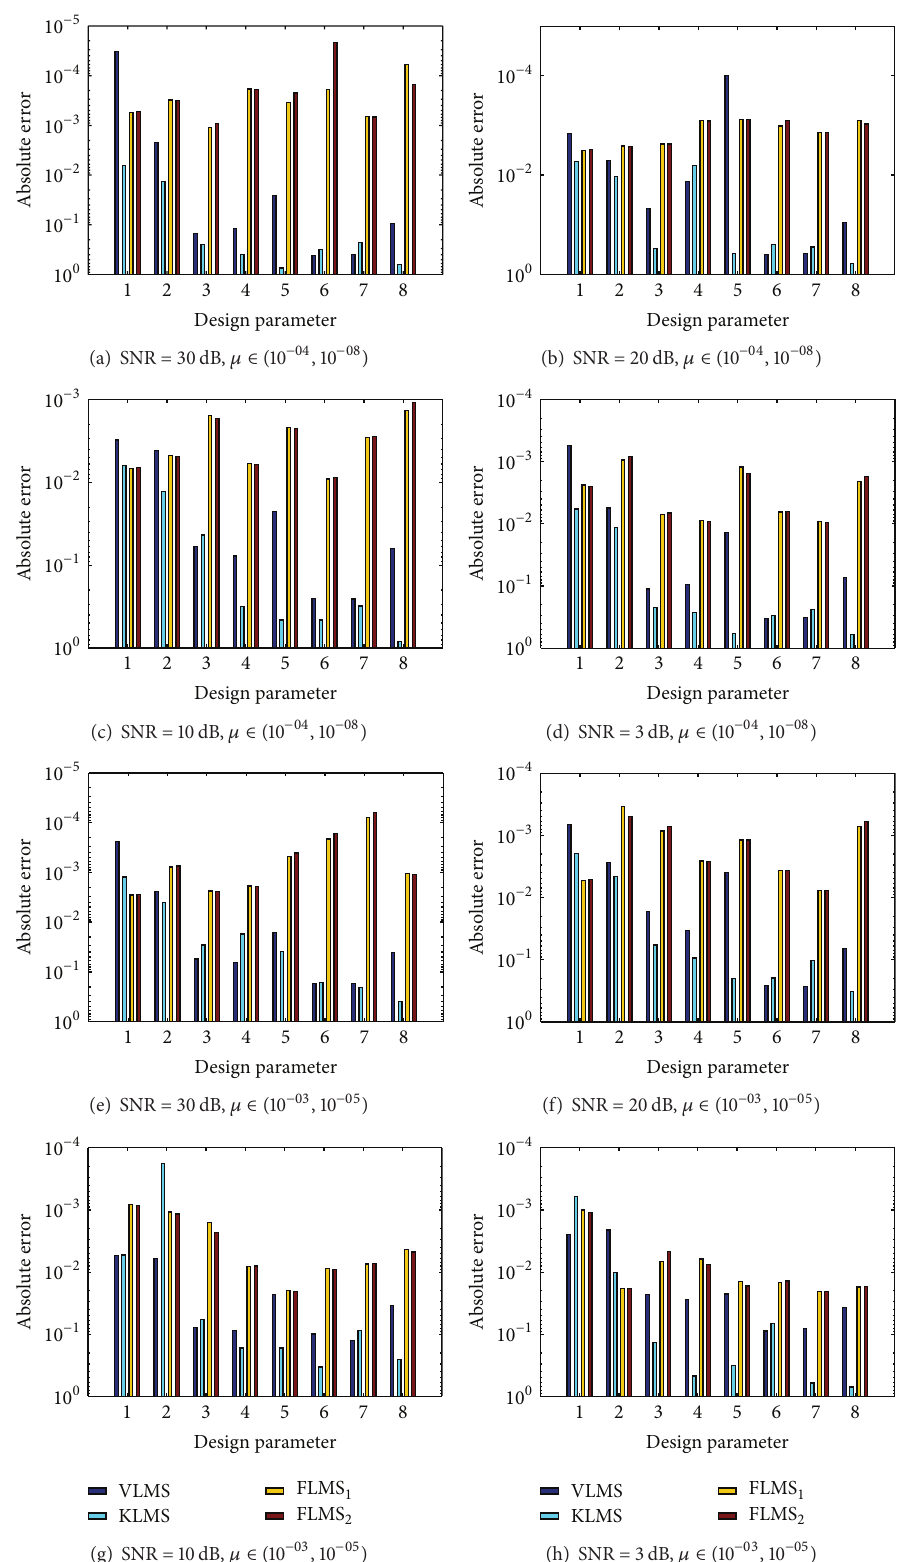
Figure 6: Comparison on the basis of absolute error from true values for INCAR model in case study